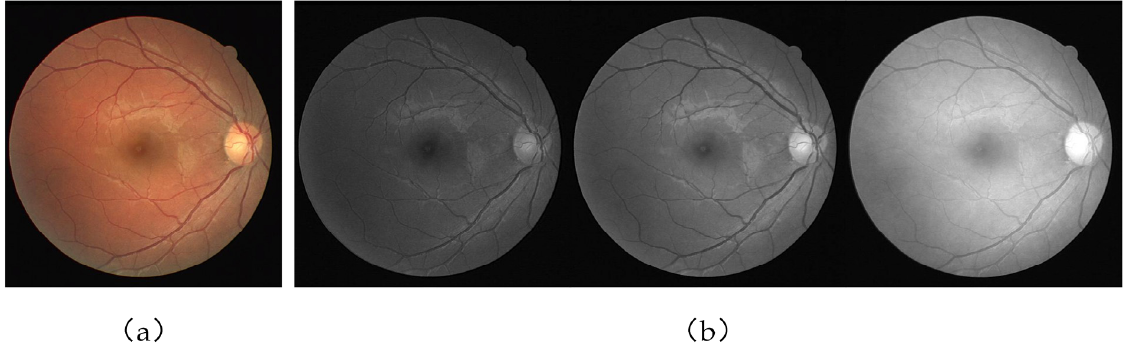
Figure 6. Examples of image preprocessing. ( a ) Original image. ( b ) Image graying and image normalization. Table 2. Effect of preprocessing on experimental data.